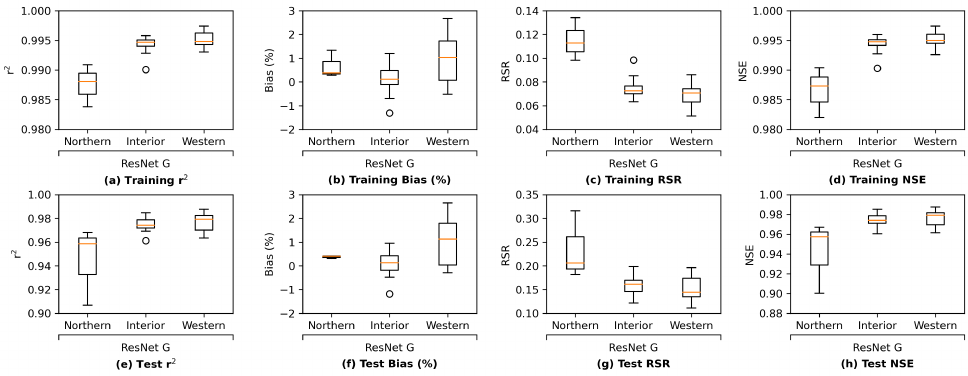
Figure A16. Box and whisker plots of four types of metrics consisting of r 2 , percent bias, RSR, and NSE on stations belonging to the northern, interior, and western Delta groups during the training (panels ( a – d )) and test (panels ( e – h )) phases of the grouped (G) ResNet model.